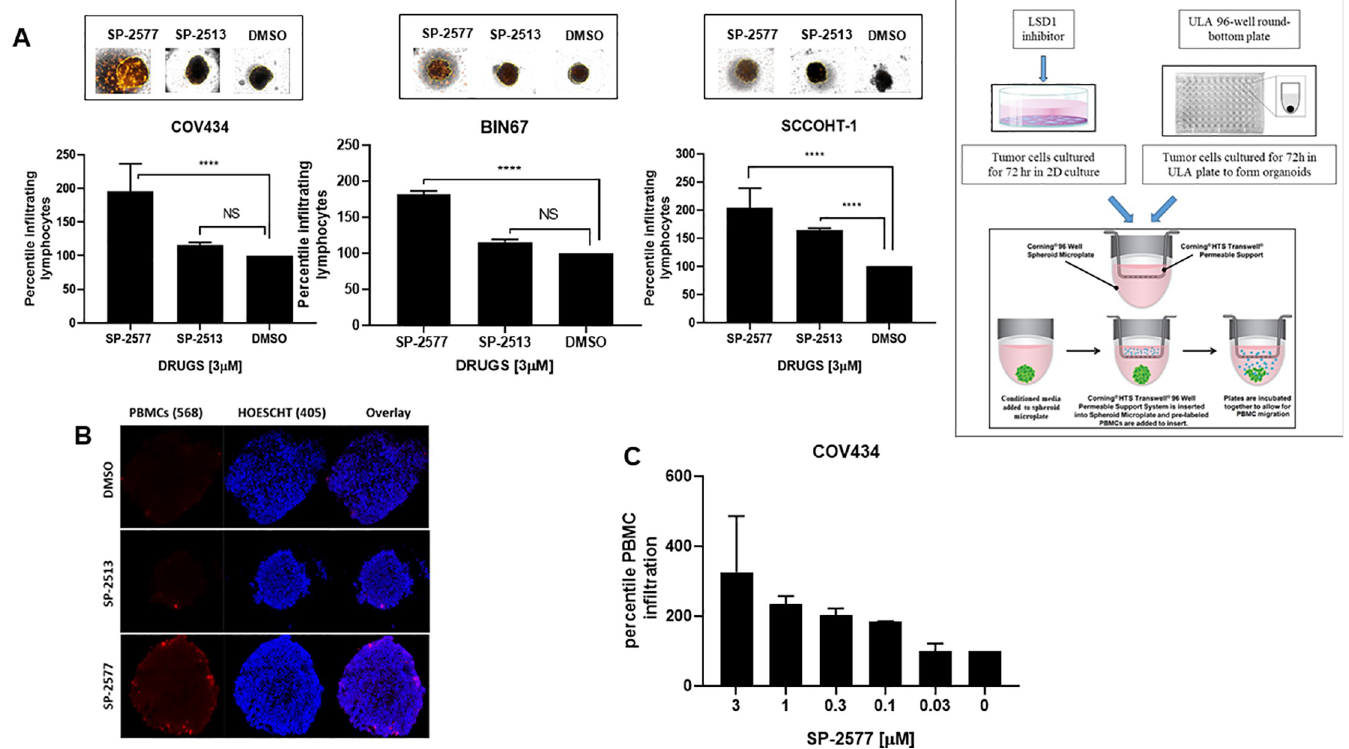
Fig 3. SP-2577 promotes lymphocyte infiltration in SCCOHT tumor organoids. ( A ) Immune infiltration assay in SCCOHT organoids imaging analysis. COV434, BIN67 and SCCOHT-1 derived-organoids were incubated with conditioned medium pretreated with 3 μ M SP-2577, SP-2513, or DMSO in the presence of RFP-tagged PBMCs. After 48 h, the levels of lymphocyte infiltration were measured by z-stack analysis by Cytation 5 imaging. P values for COV434 = < 0.0001, BIN67 = 0.0016, and SCCOHT-1 = 0.0196. Right panel: Experimental design ( B ) IF analysis: RFP-tagged lymphocyte infiltration in SCCOHT organoid microsections was assessed by analysis of RFP levels on confocal scope after 48 h co-culture in presence of SP-2577 or SP-2513 conditioned medium. ( C ) Immune infiltration assay of COV434 cells treated with increased concentration of SP-2577 for 48 h. The amount of lymphocyte infiltration correlates with SP-2577 dose.